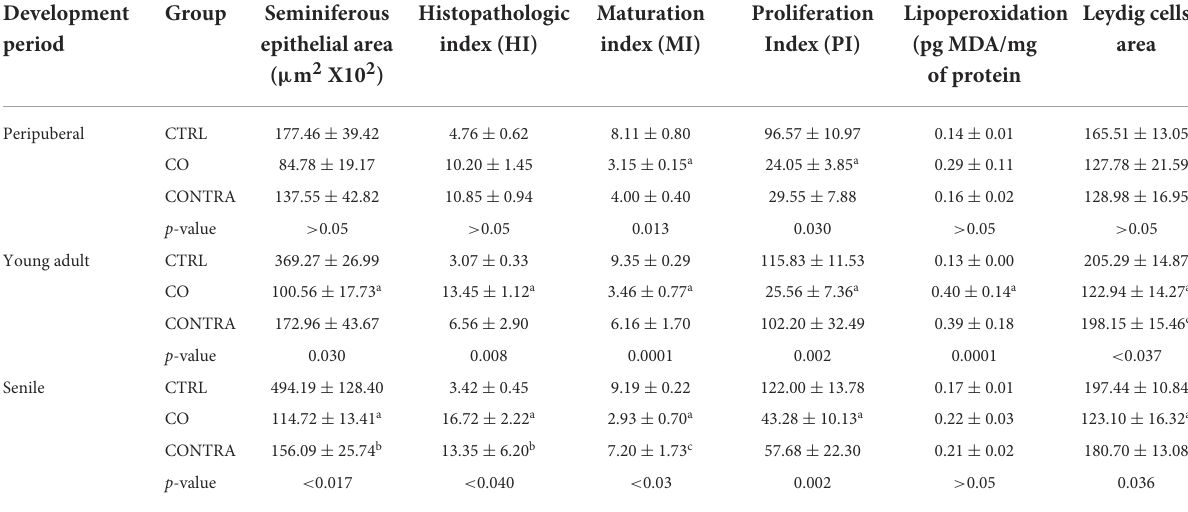
TABLE 1 Parameters evaluated in the studied groups at different stages of development of the